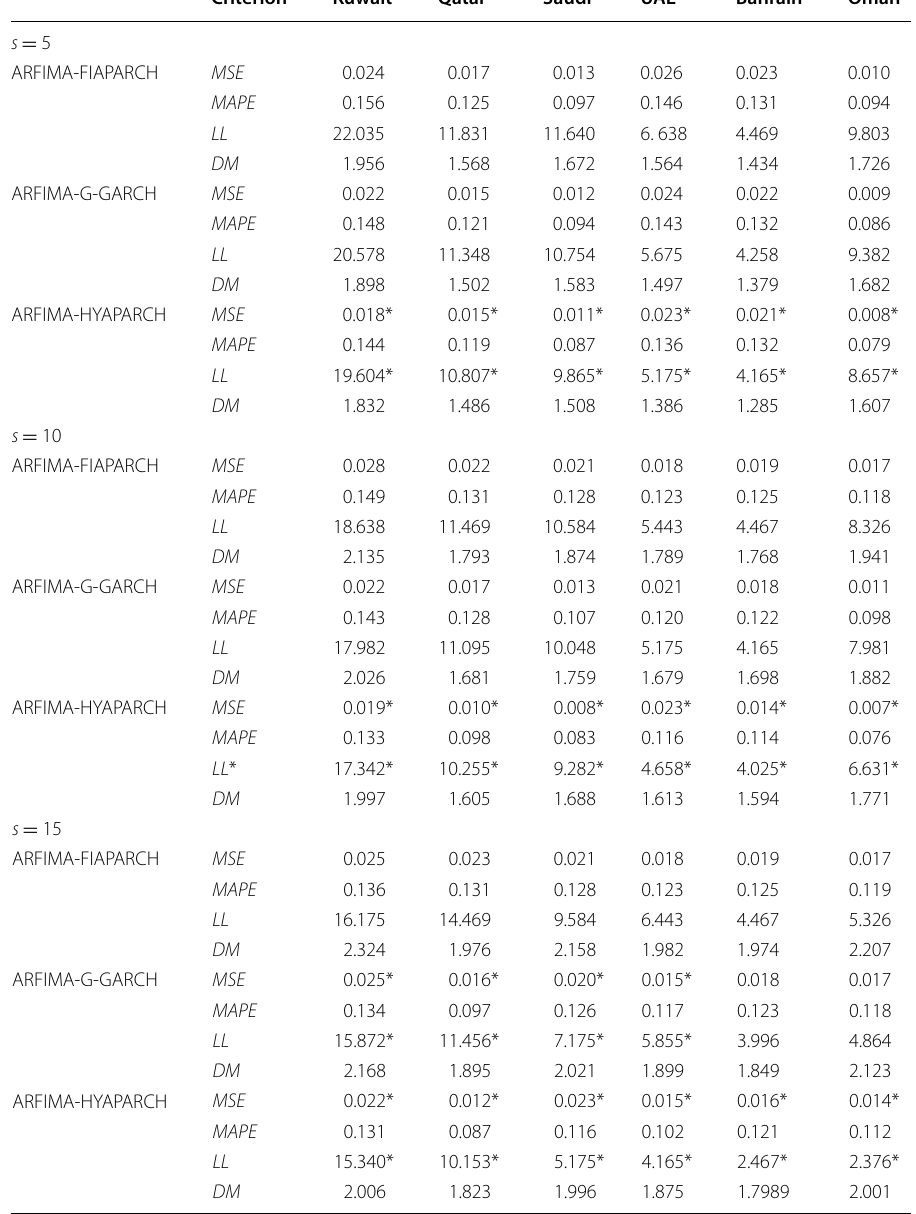
* denote significance at the 5%